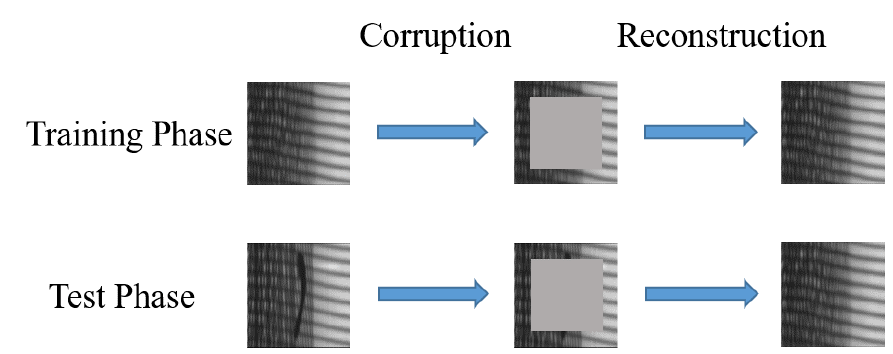
Figure 7. Procedure of image